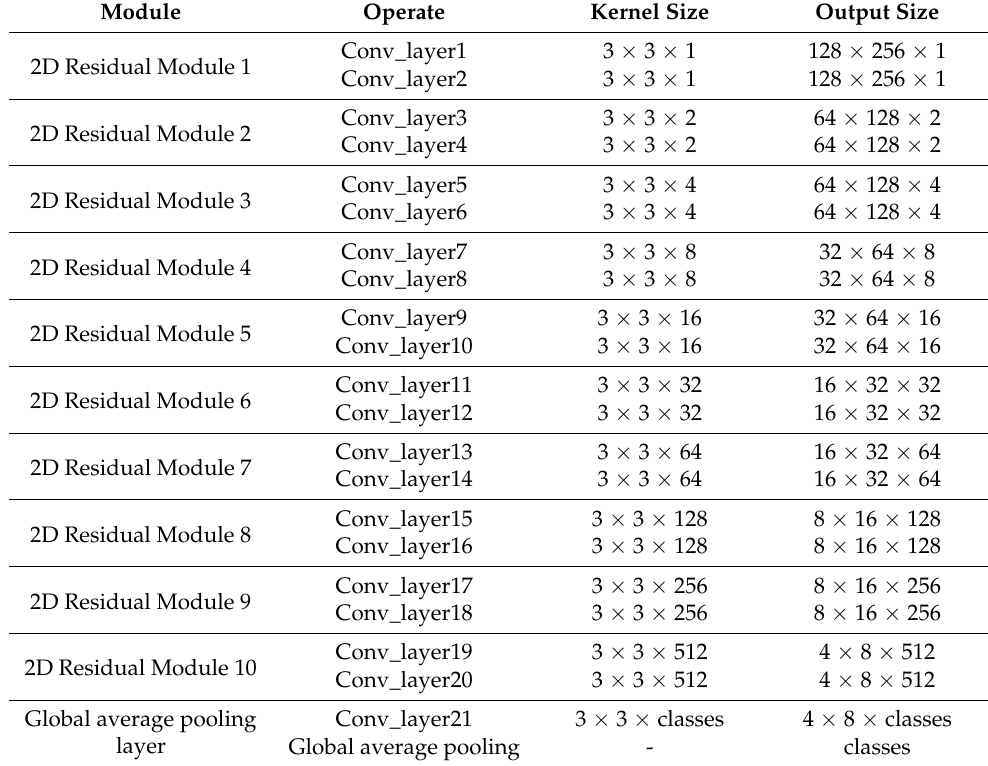
Table 2. Teacher network parameters.